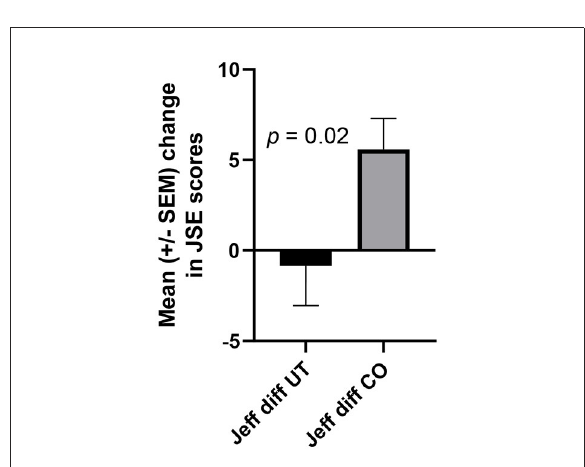
FIGURE2 The changes in students JSE scores in CO significantly exceeded those in UT. Each student’s score in August was subtracted from their score in December, and the resultant series of differences (diff) in CO ( n = 40) and UT ( n = 30) were compared statistically using an unpaired t